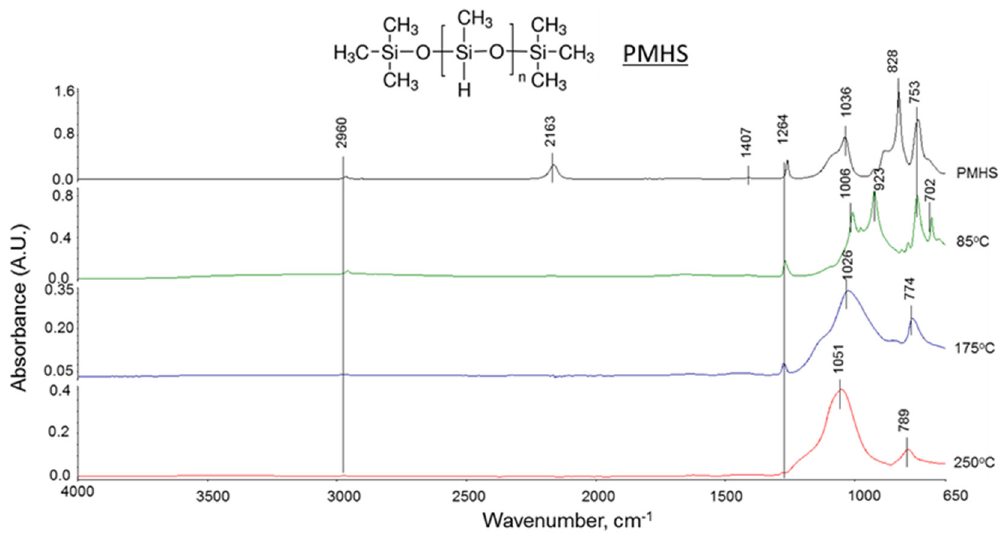
Figure 7. ATR-FTIR spectra of “as-received” PMHS, and PMHS/SMS samples cured at 85°, 175°, and 250 °C. The spectrum of PMHS/SMS blend cured at 85 °C showed two new bands at 923 and 702 cm − 1 , while the Si–H bands at 2163 and 828 cm − 1 vanished. There was also a striking shift of the Si–O–Si band from 1036 cm − 1 to a lower wavelength of 1006 cm − 1 . The band of Si–H disappeared because the group reacted with SMS. The two new bands at 923 and 702 cm − 1 are likely to belong to the reaction products. The potential contributor to these bands is nonbridging Si–O stretching ( ν Si - O ) in the Si–O − Na + complex [52–54] and Si–O stretching ( ν s Si - O ) mode in newly precipitated silica. If this interpretation is correct, the following dehydrogenation reactions between Si–H and SMS occurred at 85 °C: 2 ≡ Si–H + SiO 2 (OH) 22 − + 2Na + → 2 ≡ Si–O − Na + + 2H 2 ↑ + SiO 2 ( precipitation ) ↓ . On the other hand, a striking shift of the Si–O–Si band may be due to the rupture of Si–O–Si backbone linkages by the formation of the ≡ Si–O - Na + complex. Some investigators reported that the bond strength of Si–O–Si adjacent to this complex decreases, thereby resulting in the cleavage of Si–O–Si linkage and depolymerization [55,56]. However, we observed that at ambient temperature in the system of PMHS/SMS/FCS, PMHS preferentially reacts with SMS-ac- tivated FCS rather than with SMS alone. So, it is likely that such a complex can form in the case when unreacted PMHS remained at 85 °C. Interestingly, when the 85 °C-treated sample was autoclaved at 175 °C, the Si-O-Si band reversely shifted to a higher wavelength of 1026 cm − 1 from 1006 cm − 1 , suggesting the recovery of Si–O–Si linkages cleaved at 85 °C. The cleavage site is susceptible to hydro- thermal hydroxylation with the formation of silanol, Si–OH. The self-condensation be- tween silanols, ≡ Si–OH + OH–Si ≡ → ≡ Si–O–Si ≡ + H 2 O, results in repolymerization, –[– Si–O–Si–] n –, in an alkali hydrothermal environment [57–60]. There are two other signs of such repolymerization. As is evident from the spectrum at 175 °C, there was no band at 923 cm − 1 related to the ≡ Si–O − Na + complex, while the peak intensity of Si–CH 3 -associated bands at 1264 cm − 1 and 753 cm − 1 slightly decreased compared with that at 85 °C. In fact, the ∆ A values at the 2163 cm − 1 band at 85° and 175 °C were 0.017 and 0.014, respectively. These data suggest that the ≡ Si–O − Na + complex un- derwent hydrolytic attacks in the hydrothermal environment at 175 °C, inducing the for- mation of a silanol (Si–OH) group as the hydrolysate, ≡ Si–O − Na + + H 2 O → ≡ Si–OH + NaOH. The decreased intensity of Si-CH 3 bands may be a result of the hydrolysis-led scis- sion of ≡ Si–CH 3 bond in an alkali hydrothermal environment at an elevated temperature at 175 °C [61]. This bond scission substitutes the debonded methyl (CH 3 ) groups with hy- droxyl (OH) groups, ≡ Si–/CH 3 + H 2 O → ≡ SiOH + CH 4 (gaseous) ↑ with the formation of silanol [62]. Furthermore, the study on the hydrothermal stability of crosslinked liquid silicone